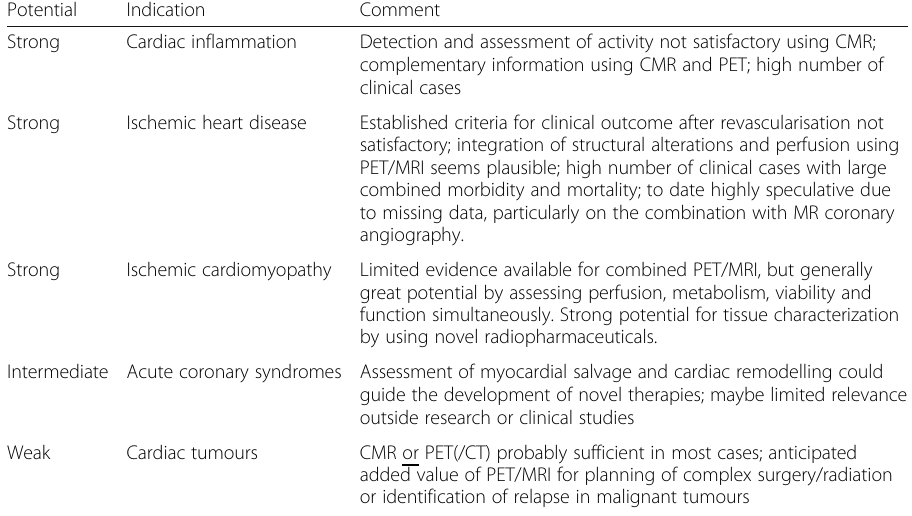
Table 1 Overview of potential clinical indications for cardiac PET/MRI Potential